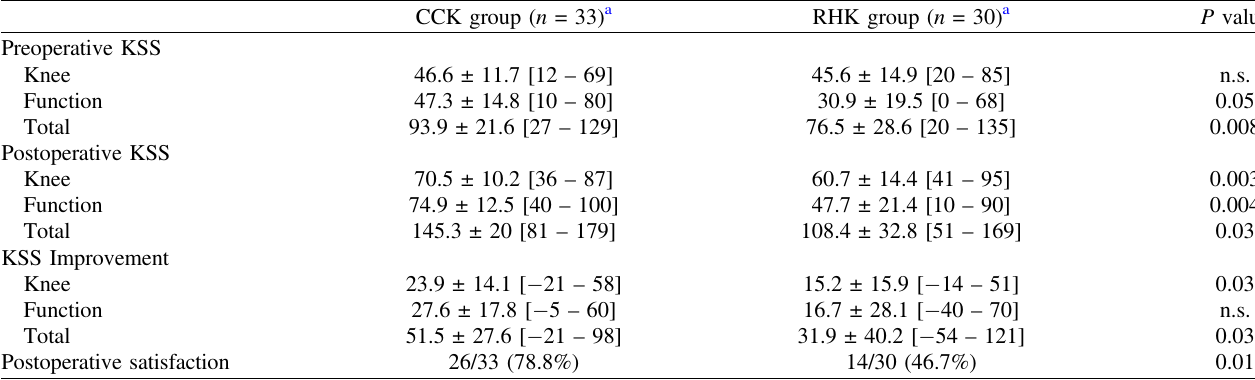
Table 2. Comparison of KSS and satisfaction by